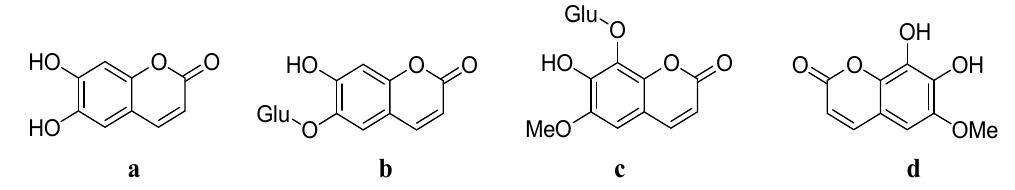
Figure 1. Structures of the contents of Cortex Fraxini.